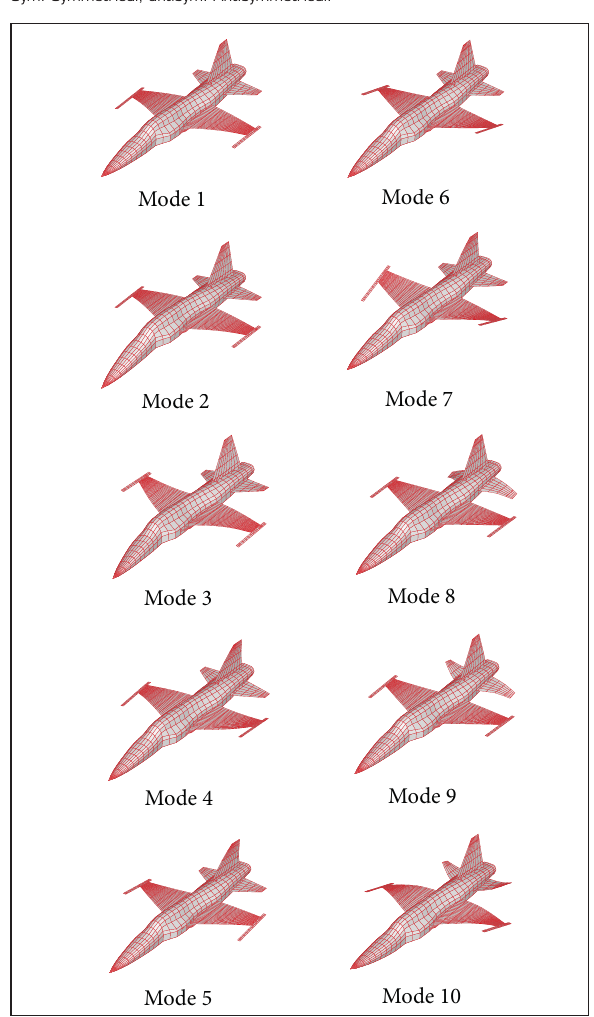
Figure 3. Selected aircraft mode shapes for aeroelastic